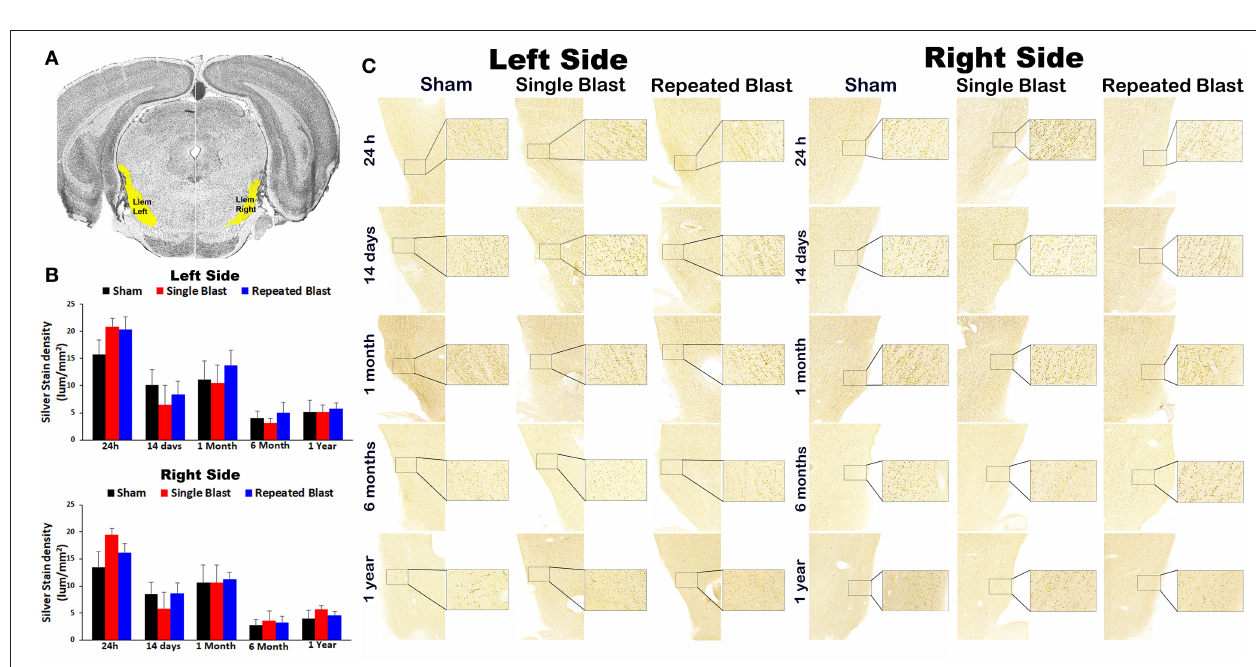
FIGURE 2 | Silver staining in the left and right medial geniculate nucleus. (A) Medial geniculate (MGen) region selected using rat brain atlas for analysis. (B) Graphics showing densitometry analysis from the left and right silver-stained MGen regions at different intervals post-blast exposures. (C) Representative silver-stained images from left and right MGen regions at different intervals after single and tightly coupled repeated blasts. Portions of sections inside rectangles are shown at higher magnification on the right. Values are expressed as mean ± SEM. Density values of single and repeated blast-exposed groups were compared to the respective sham controls ( p > 0.05, ANOVA; normal distribution; n = 4–6).